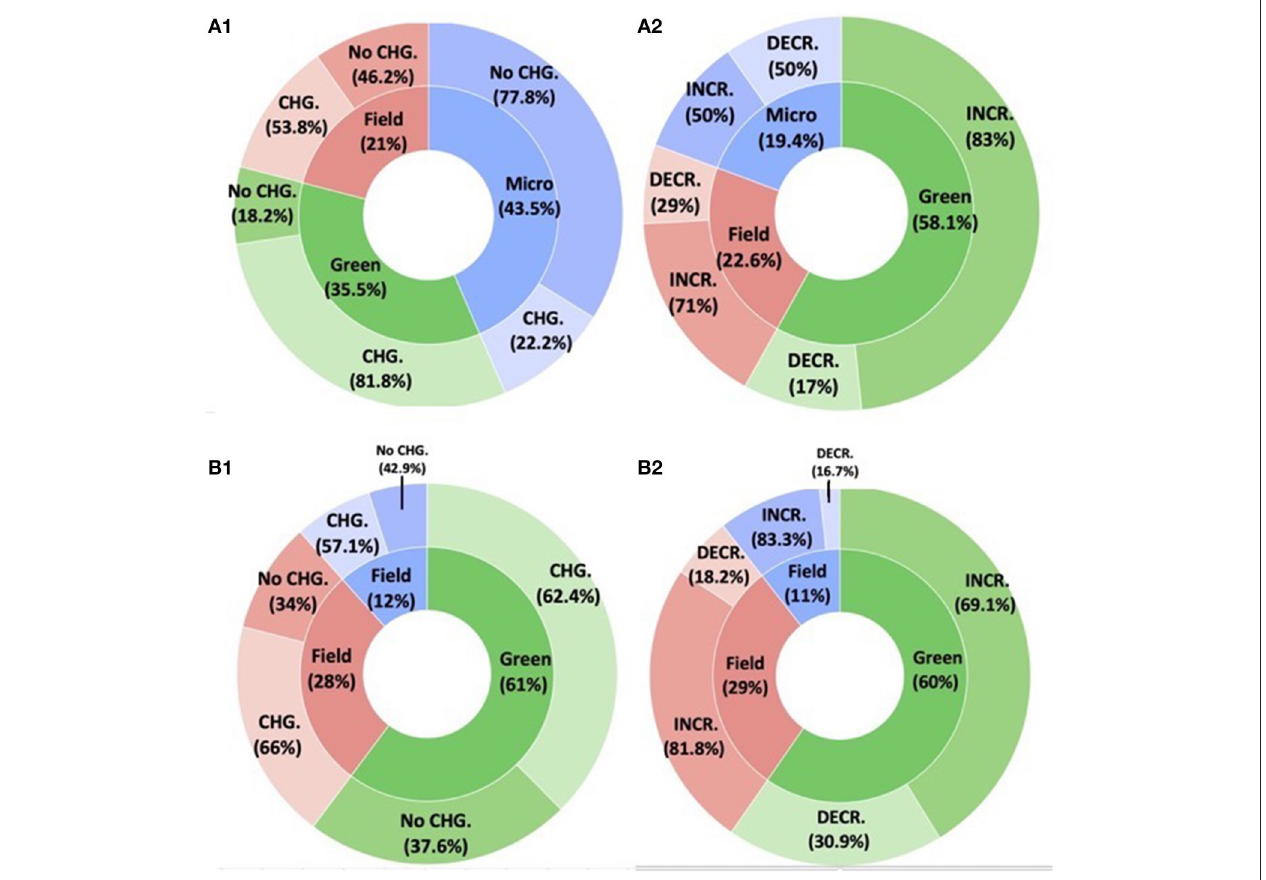
FIGURE 6 | The role of the environment to the inoculation effect on the native (A) fungal and (B) bacterial communities. (A1,B1) The inner pies demonstrate the environment category (blue = microcosm red = field and green = greenhouse). The outer rings demonstrate the number of studies that found a change or did not find a change on the (A1) native fungal and on the (B1) native bacterial community diversity. (A2,B2) Boxed pie charts demonstrate the directional community changes (increased vs. decline = outer ring) per environment category (blue = microcosm red = field and green = greenhouse) for the studies that showed SMC changes following